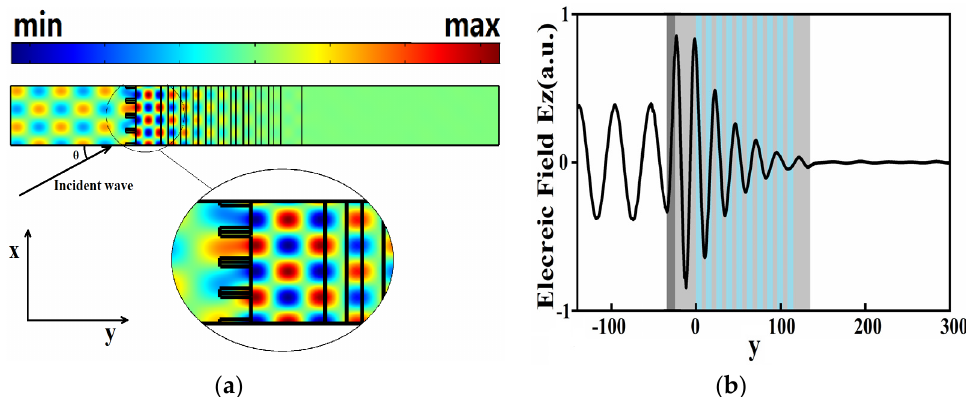
Figure 3. ( a )Electric field distribution in the y direction in the sensor Bloch surface wave (BSW) mode with the incident angle of 60°. ( b ) The electric field component in the z-direction along the y -direction, which is the top edge of the structure in ( a ) (the dark gray part is the position of the grating).